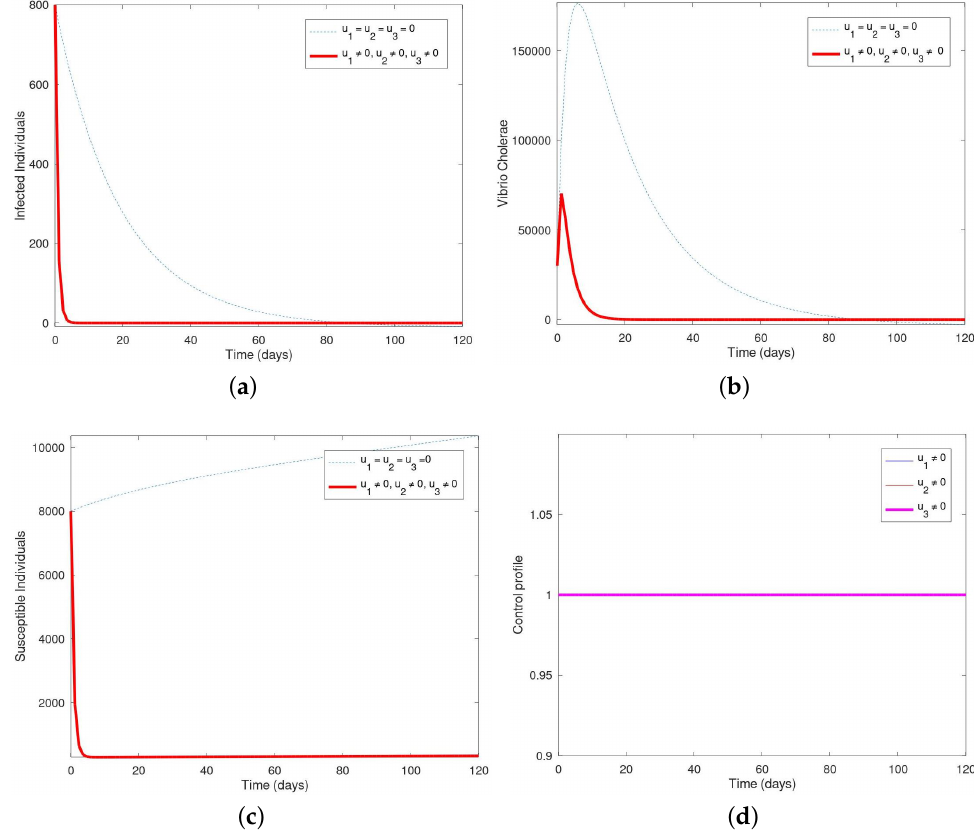
Figure 7. Simulation showing the population of ( a ) infected, ( b ) vibrio cholerae, ( c ) susceptible and ( d ) the control profile with ( u 1 , u 2 , u 3 ) . In Figure 7a, it was observed that the population of